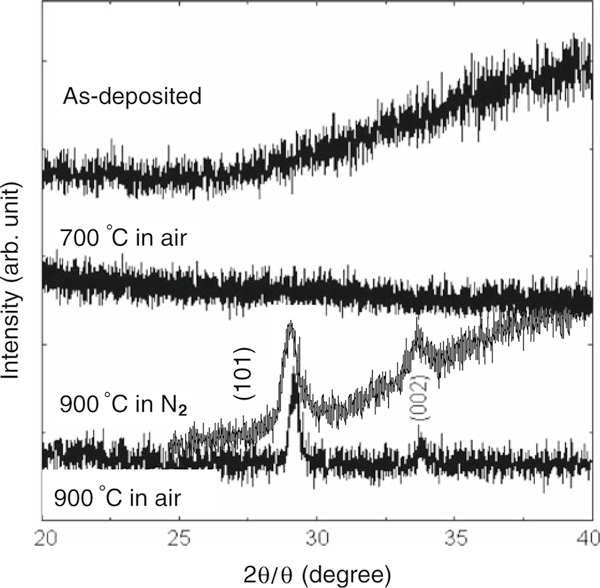
X-ray diffraction data for La0.35Zr0.65O2 films deposited by ALD and then annealed in air or N2 for 15 min at different temperatures.